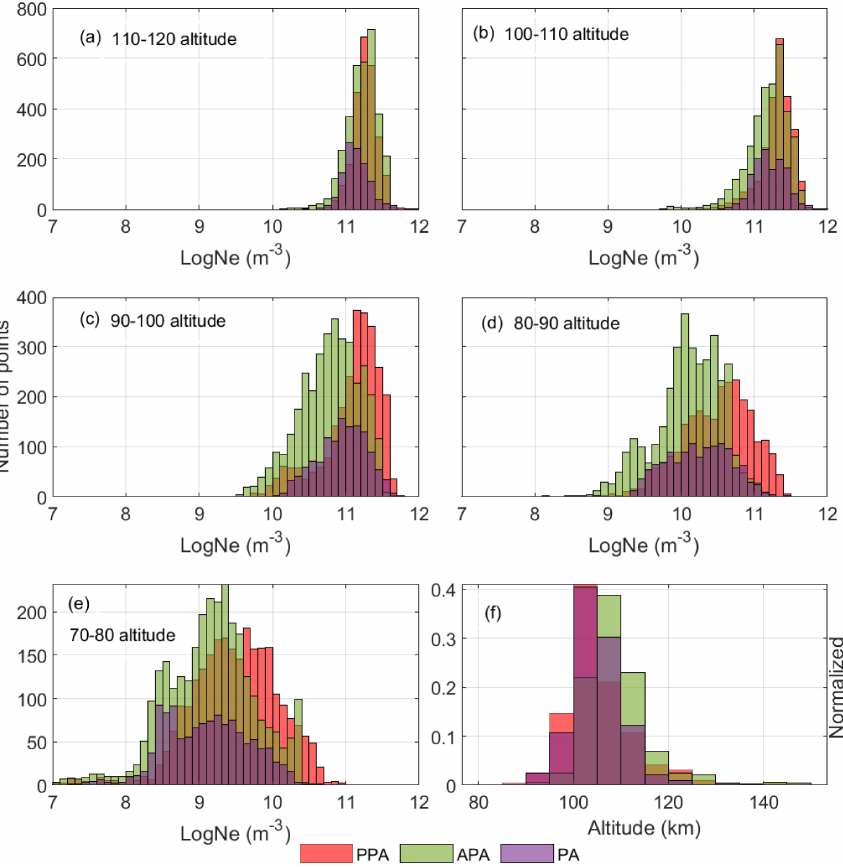
Figure 5. Histogram of EISCAT electron density measurements averaged between (a) 110 and 120km, (b) 100 and 110km, (c) 90 and 100km, (d) 80 and 90km, (e) 70 and 80km, and (f) altitude of maximum electron density during different types of pulsating